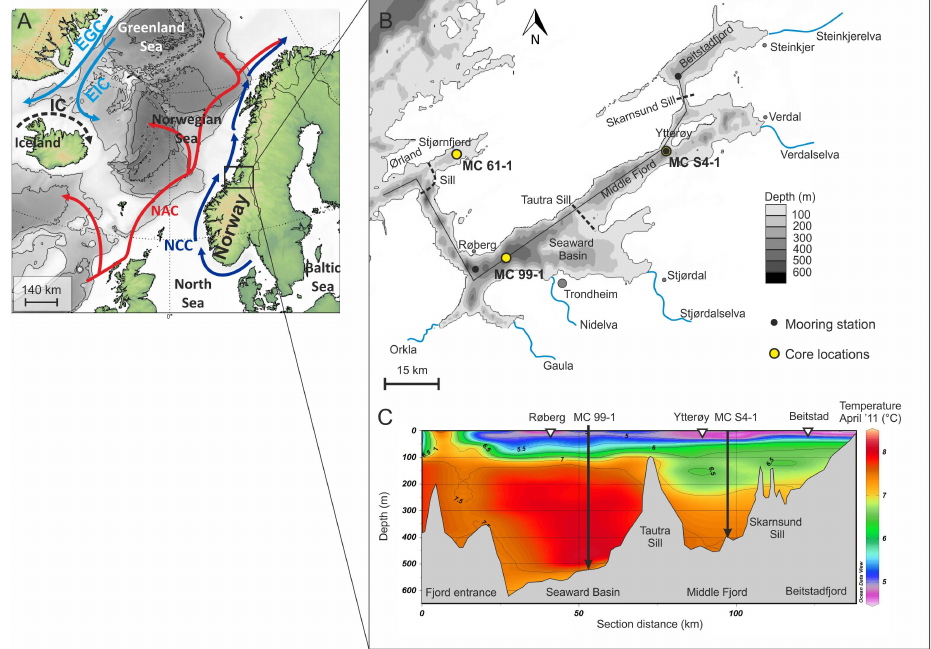
Fig. 1. (A) Surface circulation in the North Atlantic region (EGC: East Greenland Current, EIC: East Icelandic Current, IC: Irminger Current, NAC: North Atlantic Current, NCC: Norwegian Coastal Current); (B) bathymetric map of the Trondheimsfjord modified from Milzer et al. (2013). Yellow dots indicate the core locations, black dots the fixed mooring stations Røberg, Ytterøy and Beitstad referred to in the text; (C) temperature structure of the water column along the fjord axis in April 2011 (modified from Milzer et al., 2013); locations of MC 99-1 and MC S4-1 (black arrows) and the mooring stations Røberg, Ytterøy and Beitstad (white triangles) are indicated along the fjord axis. The location of MC 61-1 is outside the cross